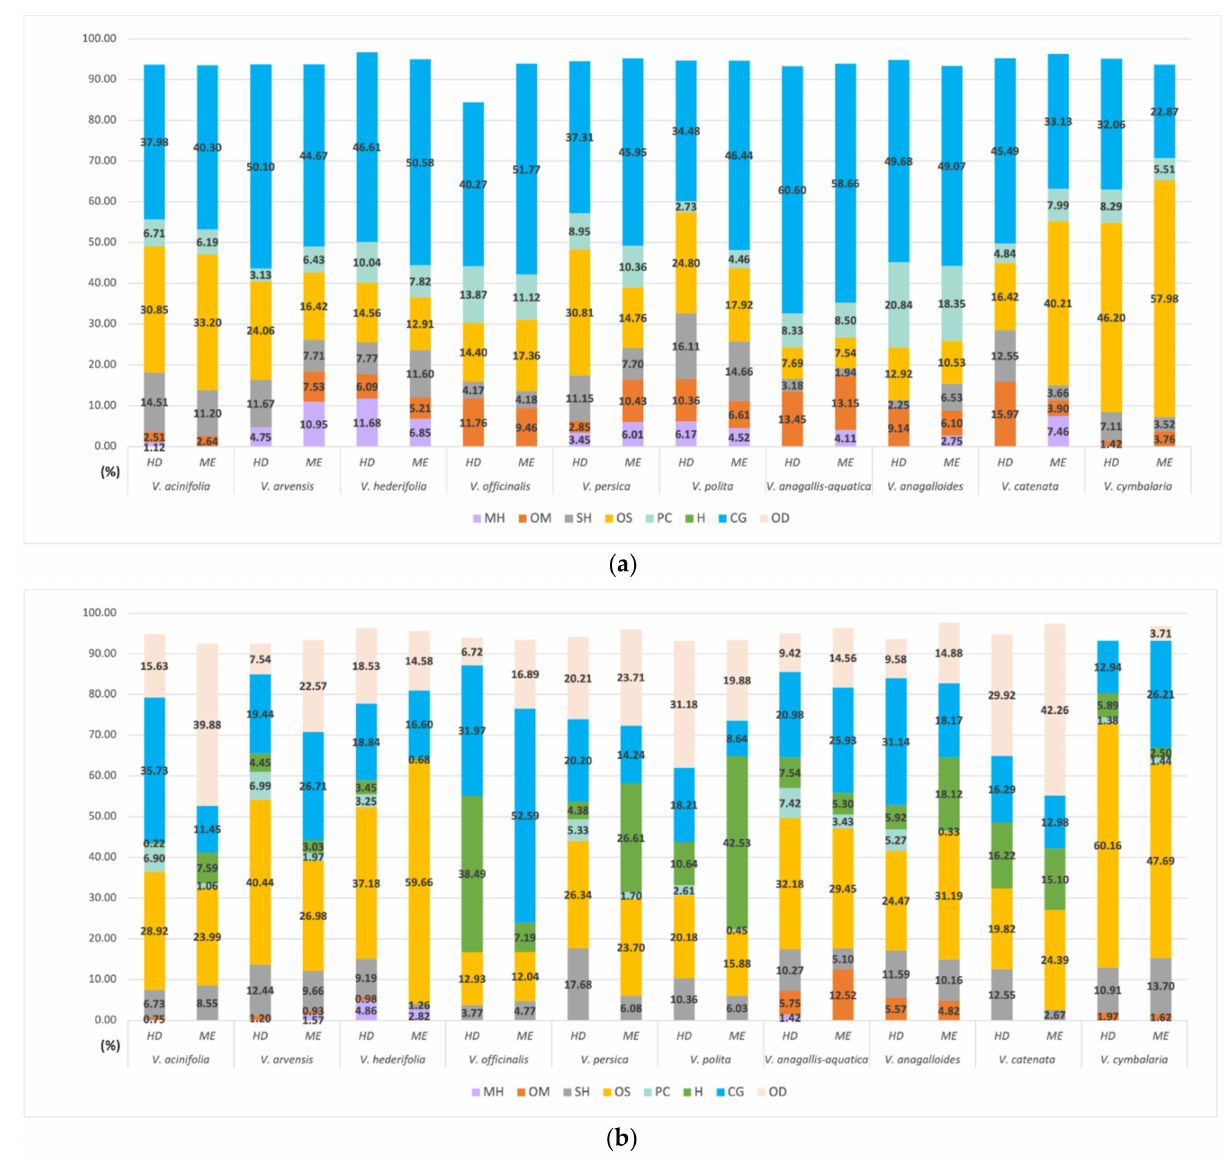
Figure 1. Relative content of hydrosol volatiles in 10 Veronica species divided into eight categories: monoterpene hydrocarbons (MH), oxygenated monoterpenes (OM), sesquiterpene hydrocarbons (SH), oxygenated sesquiterpenes (OS), oxygenated diterpene (OD), phenolic compounds (PD), hydro- carbons (H), and a common group (CG) of acids, alcohols, and esters. ( a ) categories for hydrosols from HD and MAE; ( b ) categories for LLs from HD and